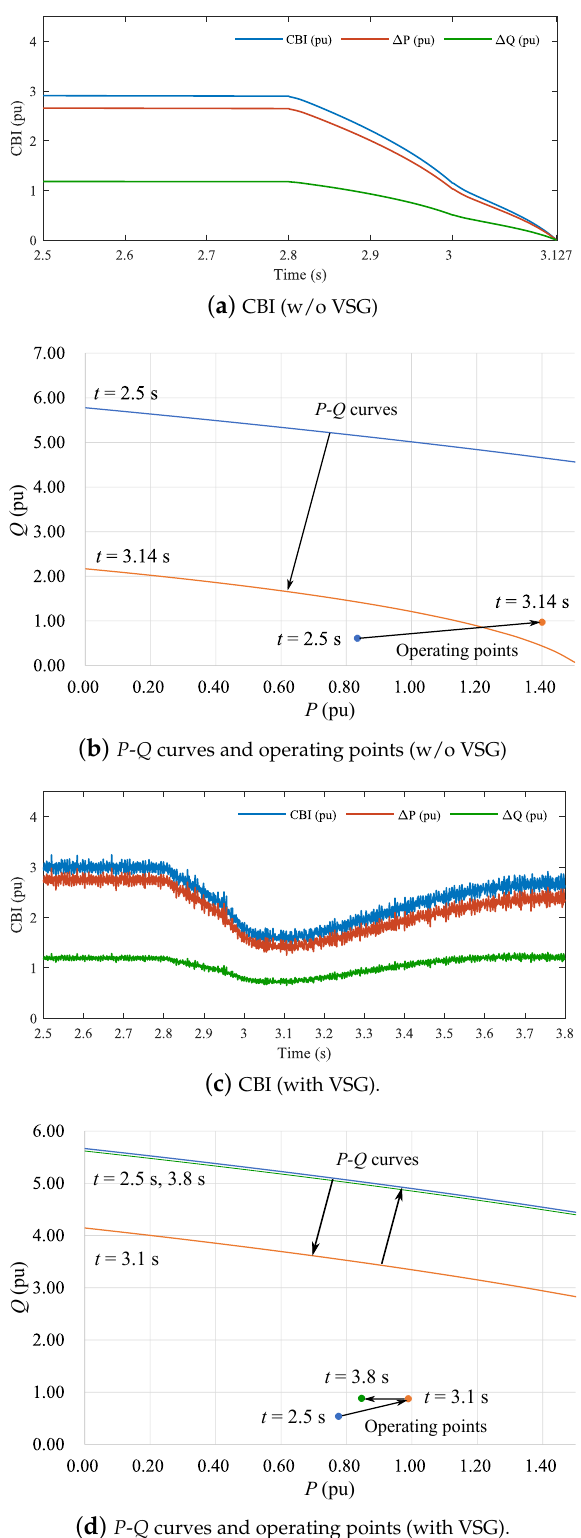
Figure 15. Critical boundary index (CBI) in Case 1.2 with/without